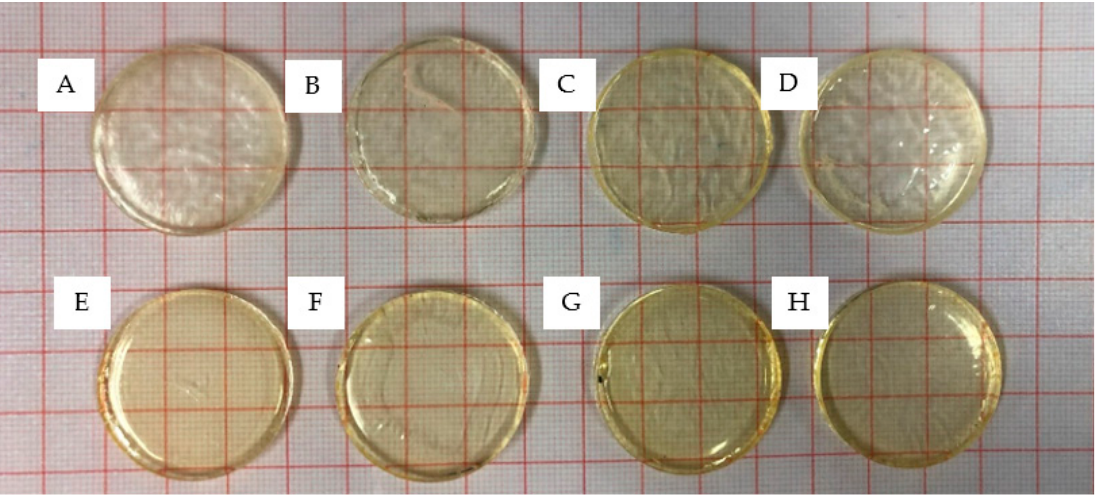
Figure 2. PNVCL xerogels fabricated with varying proportions of VAc/NVP with 0.1 wt% Irgacure ® 2959 initiator: ( A ) B1: P(NVCL90-VAc10), ( B ) B2: P(NVCL80-VAc20), ( C ) B3: P(NVCL70VAc30), ( D ) B4:P(NVCL60-VAc40), ( E ) C1:P(NVCL90-NVP10), ( F ) C2:P(NVCL80-NVP20), ( G ) C3:P(NVCL70NVP30), and ( H )